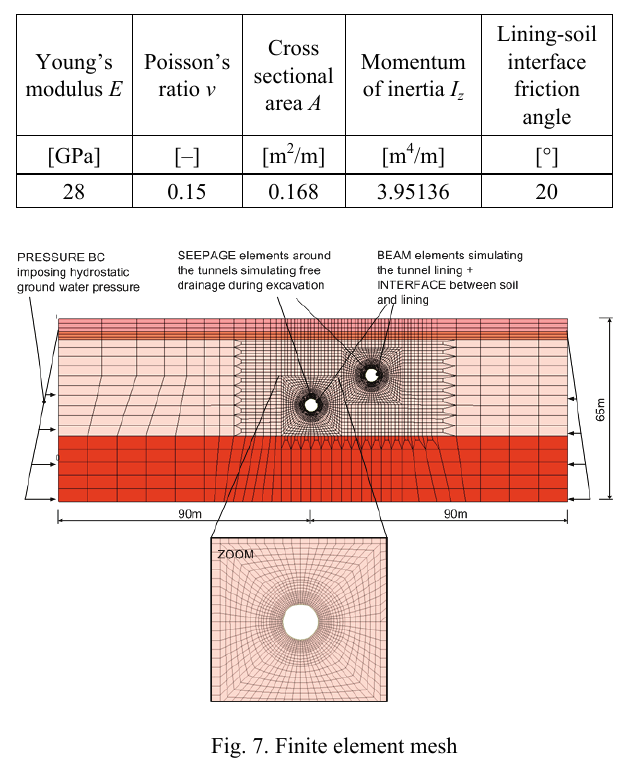
Table 2. Tunnel lining parameters